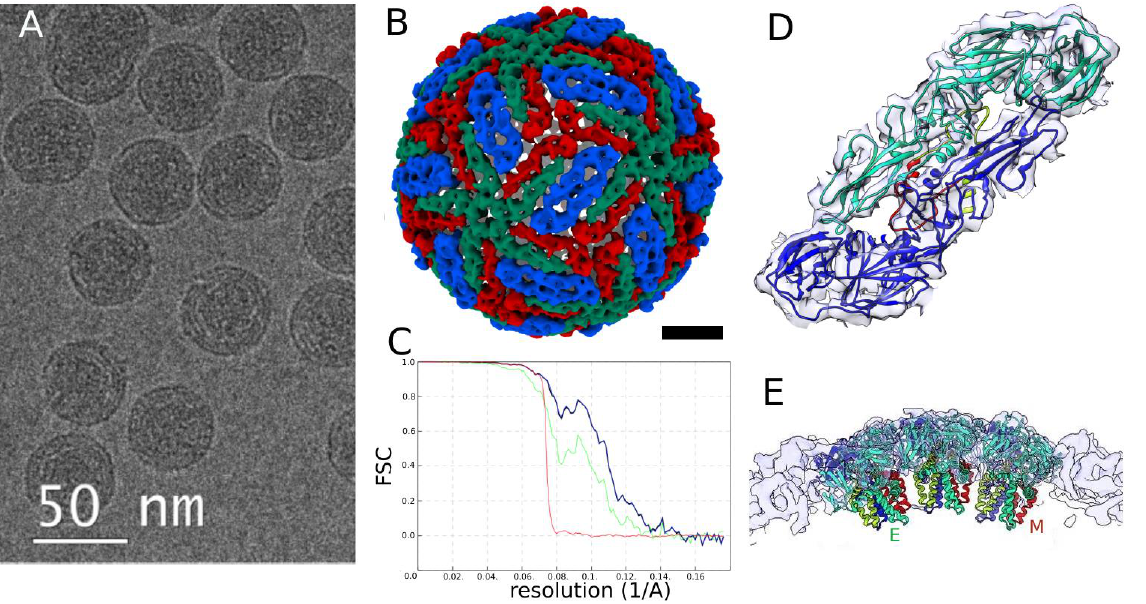
Figure 3. Cryo-EM study of inactivated TBEV. ( A ) Cryo-EM image of TBEV virions, scale bar is 50 nm; ( B ) Density map reconstructed from projections by single particle analysis, scale bar is 10 nm; ( C ) Fourier shell correlation plot: green – unmasked half-maps, blue – masked half-maps, red – phase randomized masked half-maps, black – corrected, ( D ) E protein dimer, two 5O6A models are docked into EM density, viewed from the surface of the virion, and ( E ) cross-section of the capsid shell. E proteins (marked E) are colored cyan and blue, and M proteins (marked M) are colored red and light green.